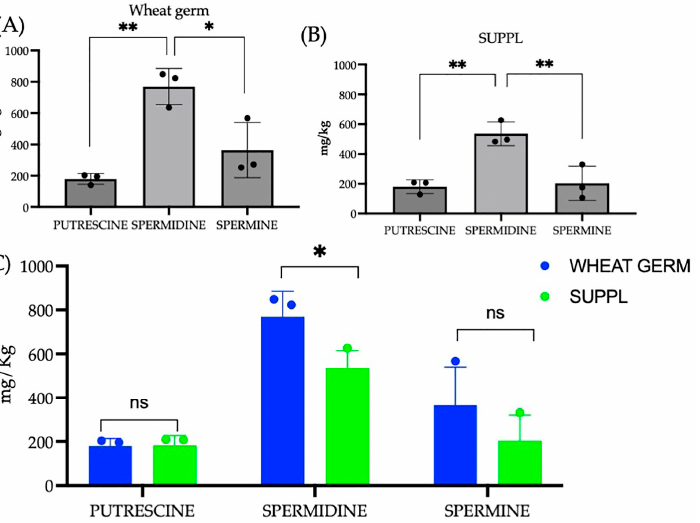
Figure 1. Polyamine content (putrescine, spermidine and spermine) in both the pressed wheat germ source ( A ) and the supplement ( B ) with a statistical comparison between the pressed wheat germ and supplement ( C ). Significant differences were represented as follows: ns p ≥ 0.05, * 0.01 < p < 0.05, ** 0.001 < p < 0.01. The black dots indicate the positioning of the individual replicates within the bar for each